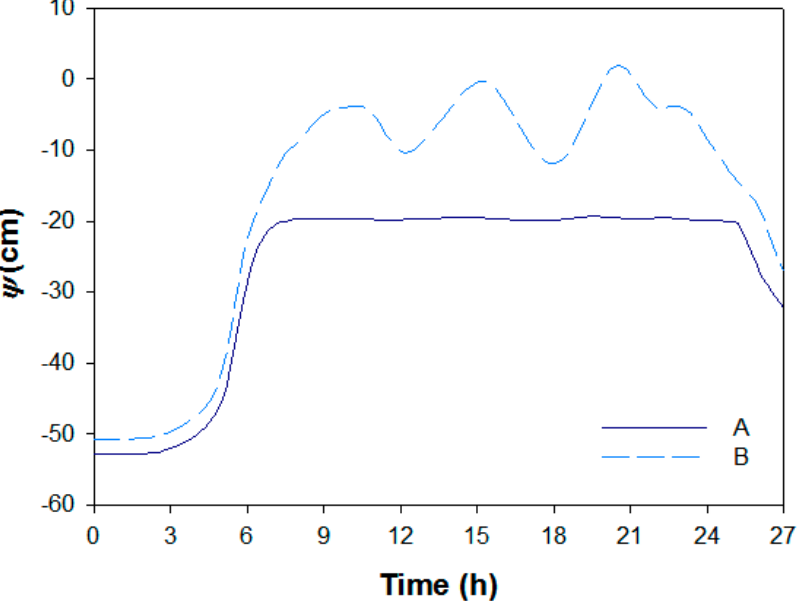
Figure 11. Simulated results of groundwater (pressure head varied with time, 1 m below ground at Locations A and B during Typhoon Meigi).